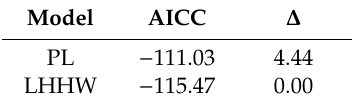
Table 6. Akaike information criterion (AICC) for model selection.